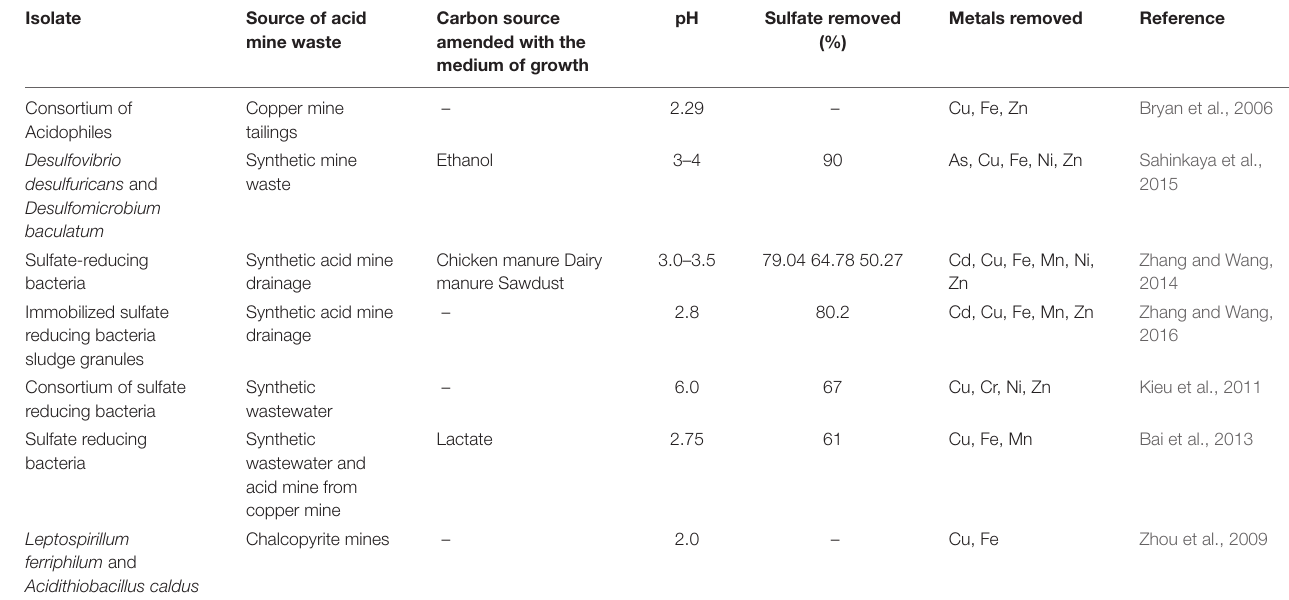
TABLE 1 | Microbial remediation of acid mine tailings wastes.